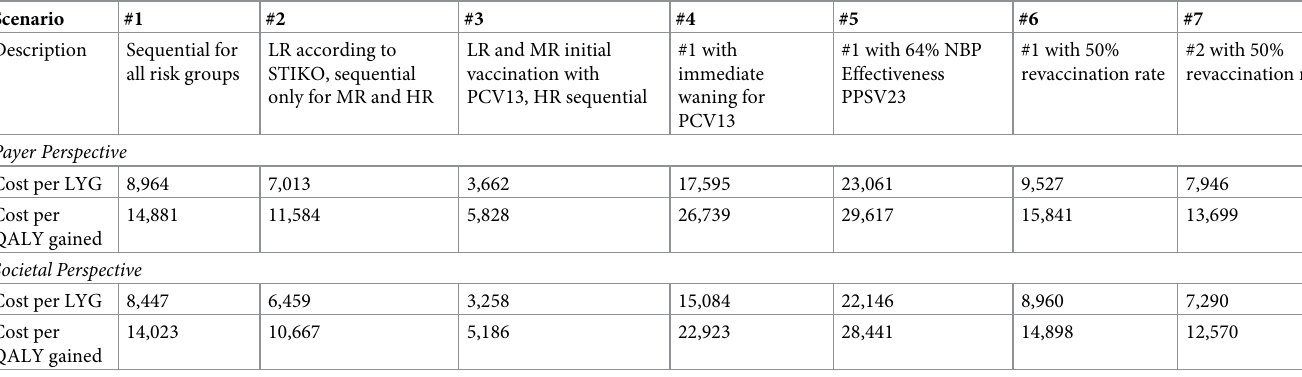
Table 7. Incremental cost-effectiveness ratios (ICER) over all scenarios (mean values). Scenario